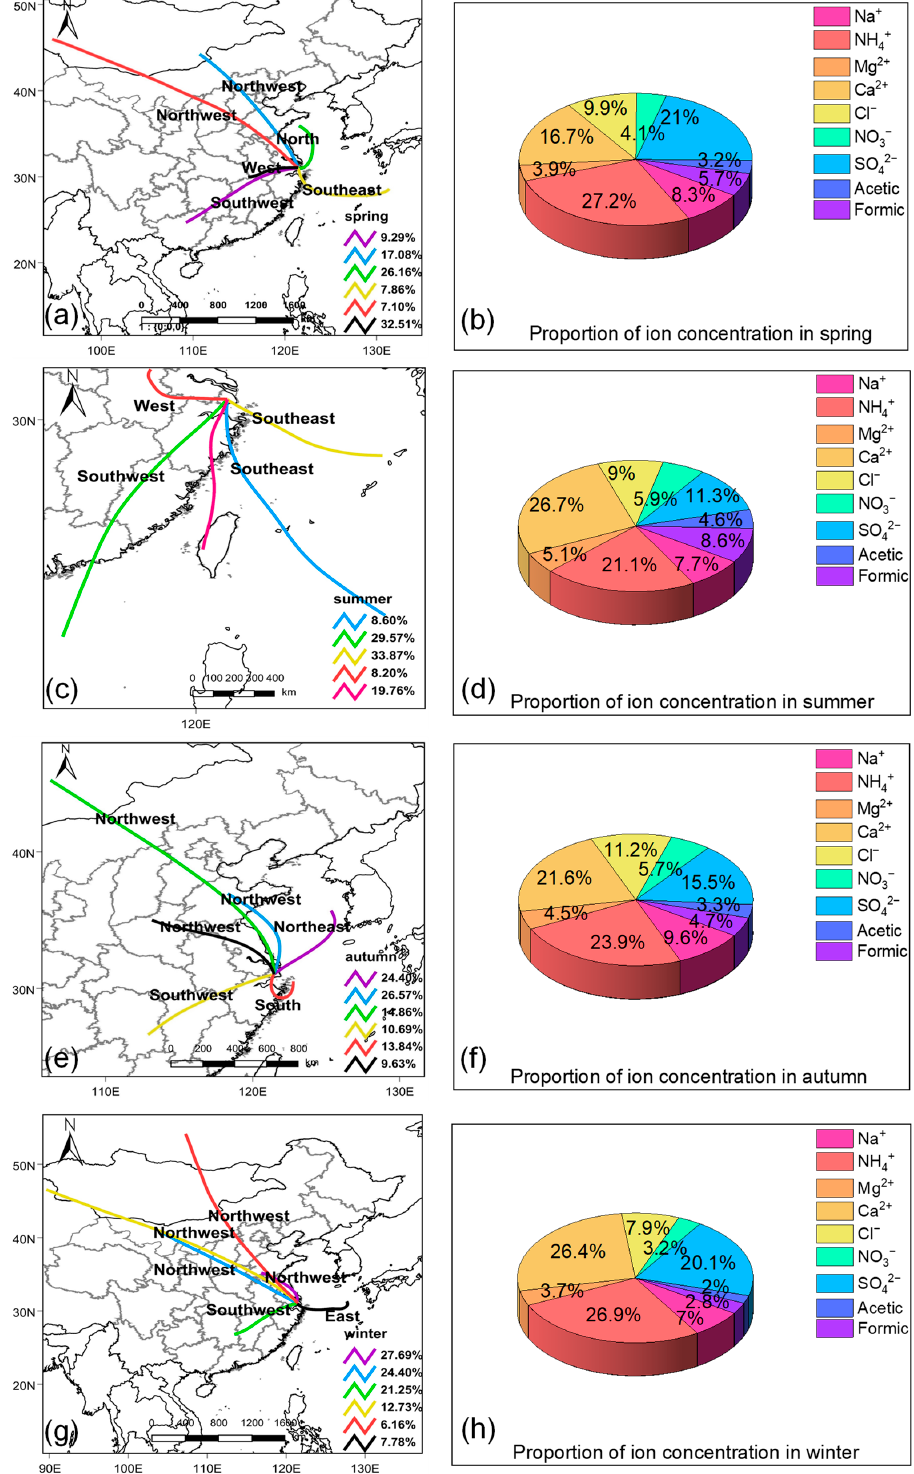
Figure 5. Backward trajectory of the major air mass clusters arriving at the sampling site and pie chart of ion concentrations in rainfalls in ( a , b ) spring, ( c , d ) summer, ( e , f ) autumn, and ( g , h ) winter.